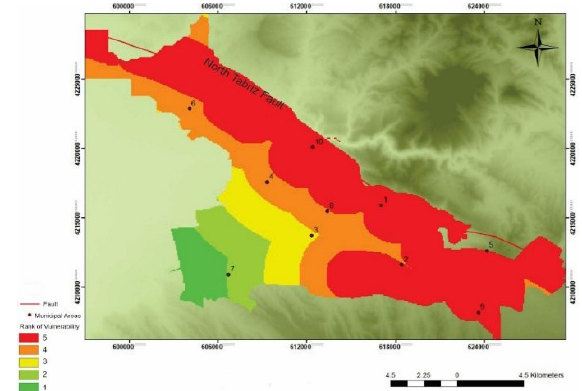
Fig. 2. Seismic vulnerability map of Tabriz City based on distance from North Tabriz Fault zone Slope Slopes